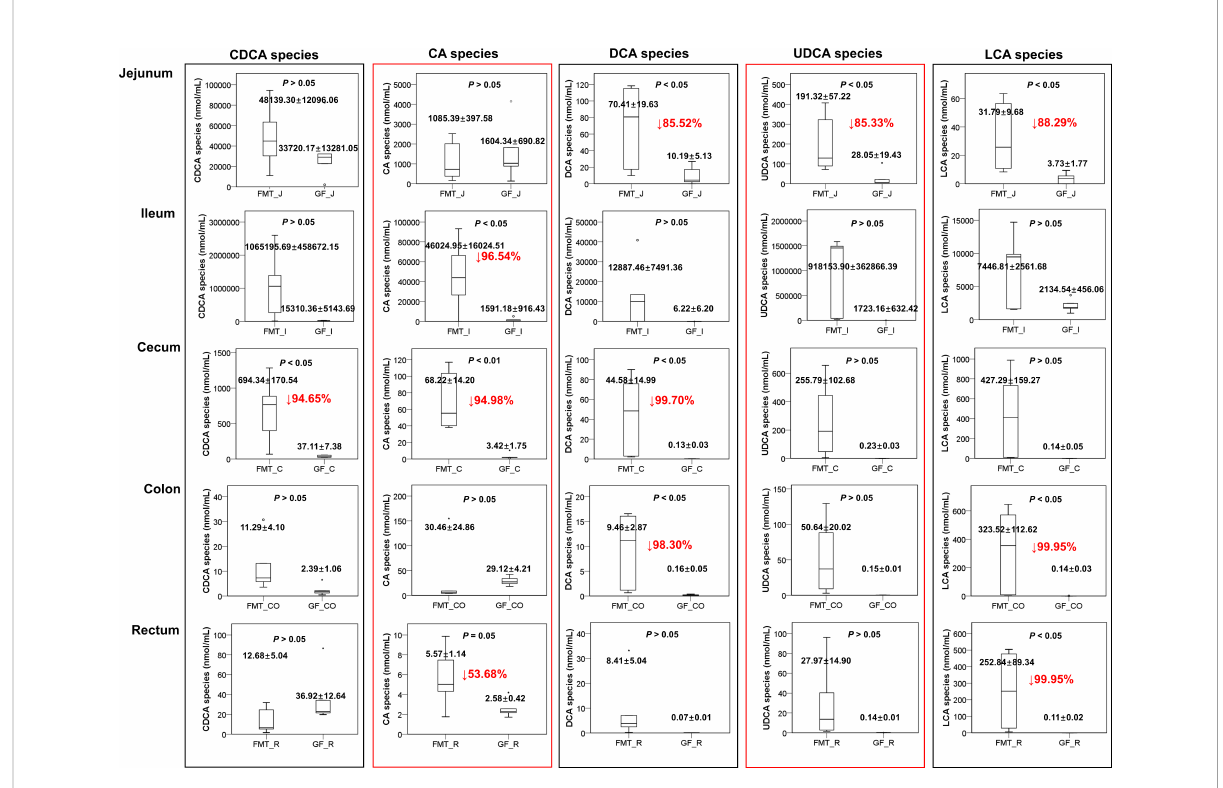
FIGURE 3 Performance of other BA species in the FMT and GF groups, except HCA species. CDCA species: GCDCA, TCDCA, and CDCA; CA species: CA, GCA, TCA, UCA, and ACA; DCA species: DCA, TDCA, GDCA; UDCA species: UDCA, GUDCA, and TUDCA; LCA species: LCA, GLCA, and TLCA. Mean values ± SE are plotted; n = 5 samples in the GF group, n = 6 samples in the FMT group. Red values with a down arrow represent the percentage reduction (%) of BA in the GF group compared to the FMT group. The circle ˚ or the symbol * represents the outliers in the data batch using a boxplot